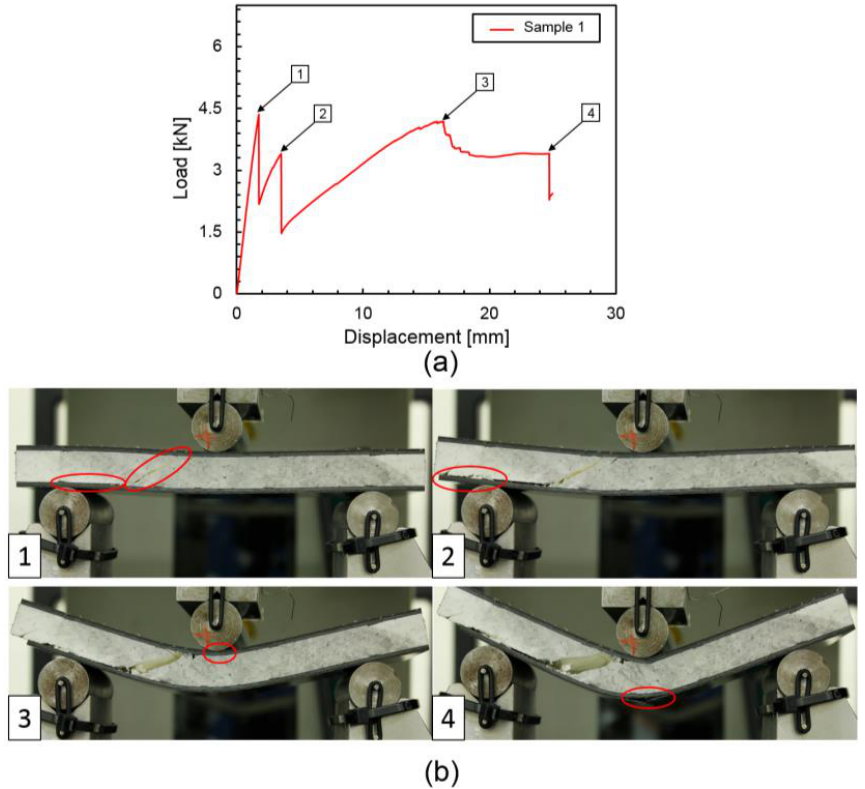
Figure 5. ( a ) Experimental load – displacement curve and ( b ) four images of failure development for sample with ‘Configuration 1’. The red ellipses highlight the various types of damage indicated in the text.